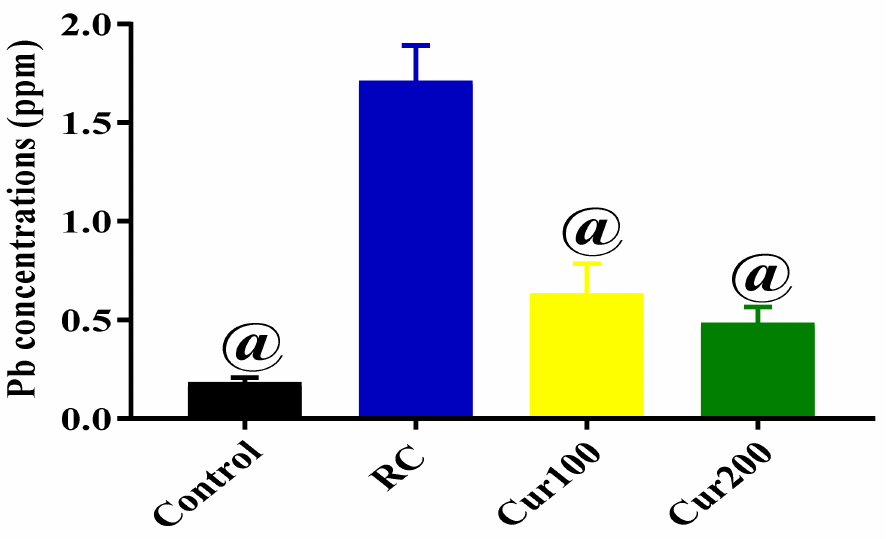
Figure14. ConcentrationofPbinrats’cerebellumsafteroraladministrationofcurcuminandwithdrawal of Pb acetate for four weeks. Data are represented as mean ± SEM (n = 3); @ p < 0.05 vs.